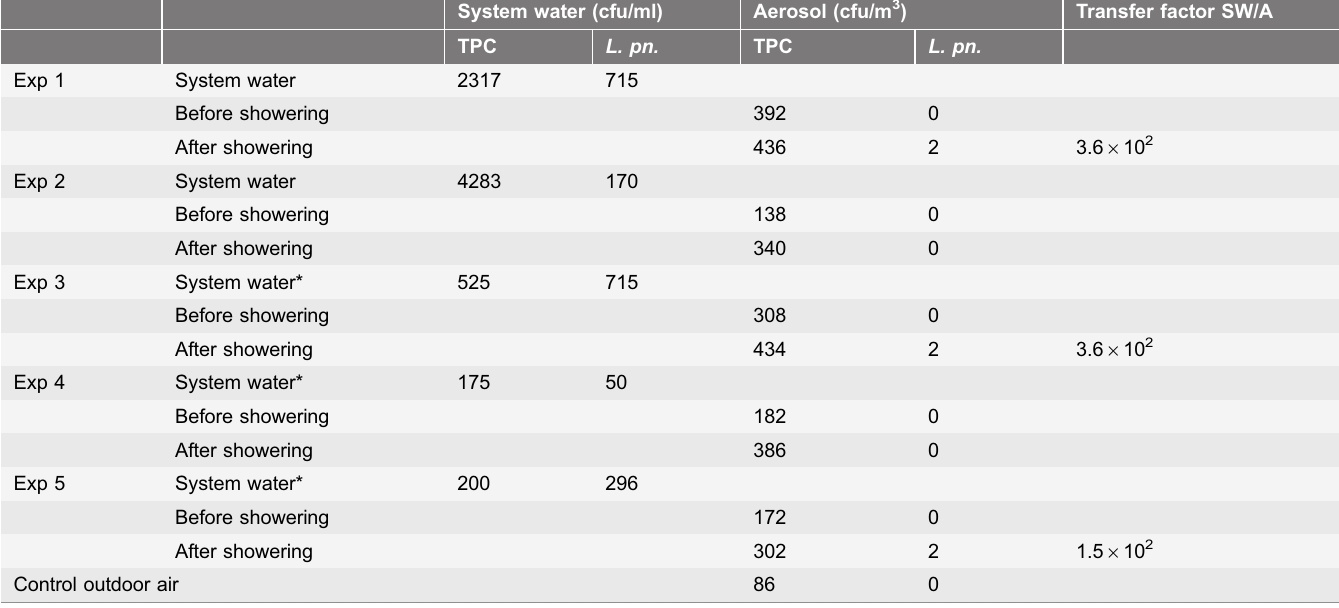
Table 3. Transfer of L. pneumophila (L. pn.) and TPC from shower water to aerosol.